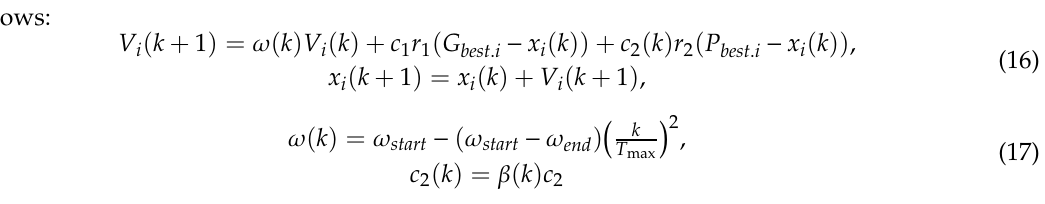
Table 5. Part of the training and test data.